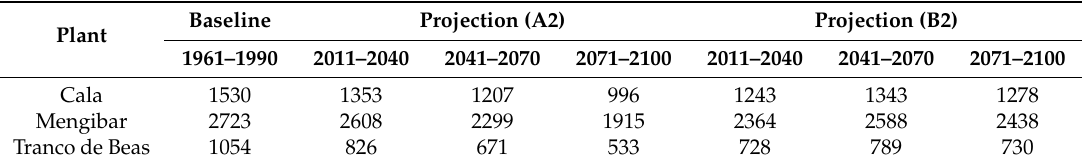
Table 3. Historical and projected production to power ratio (average annual production